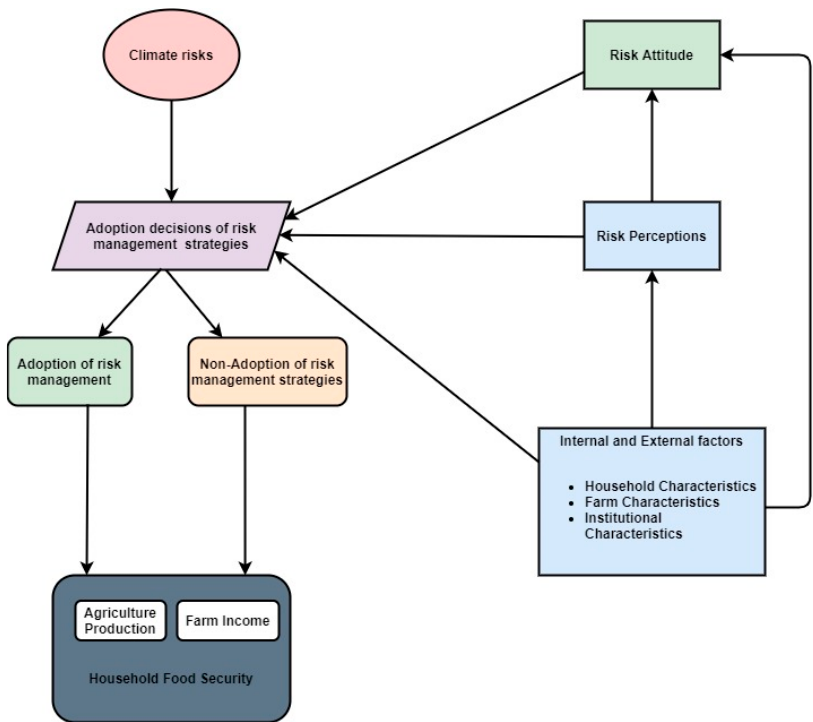
Figure 1. Conceptual model .